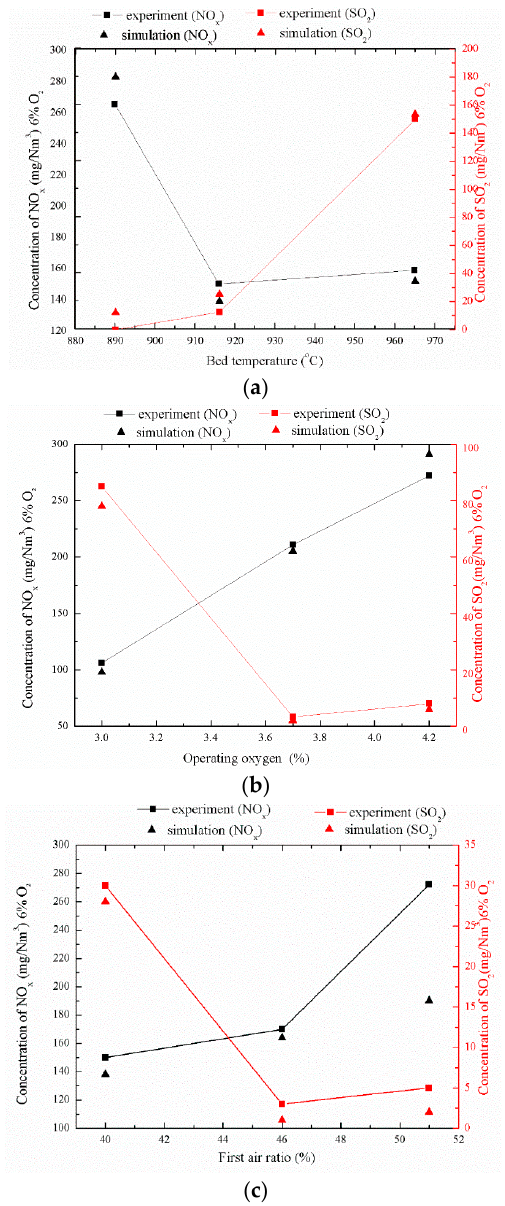
Figure 13. Three factors affecting pollutant emissions. ( a ) Effect of bed temperature on pollutant emissions; ( b ) Effect of operating oxygen on pollutant emissions; ( c ) Effect of first air ratio on pollutant emissions.